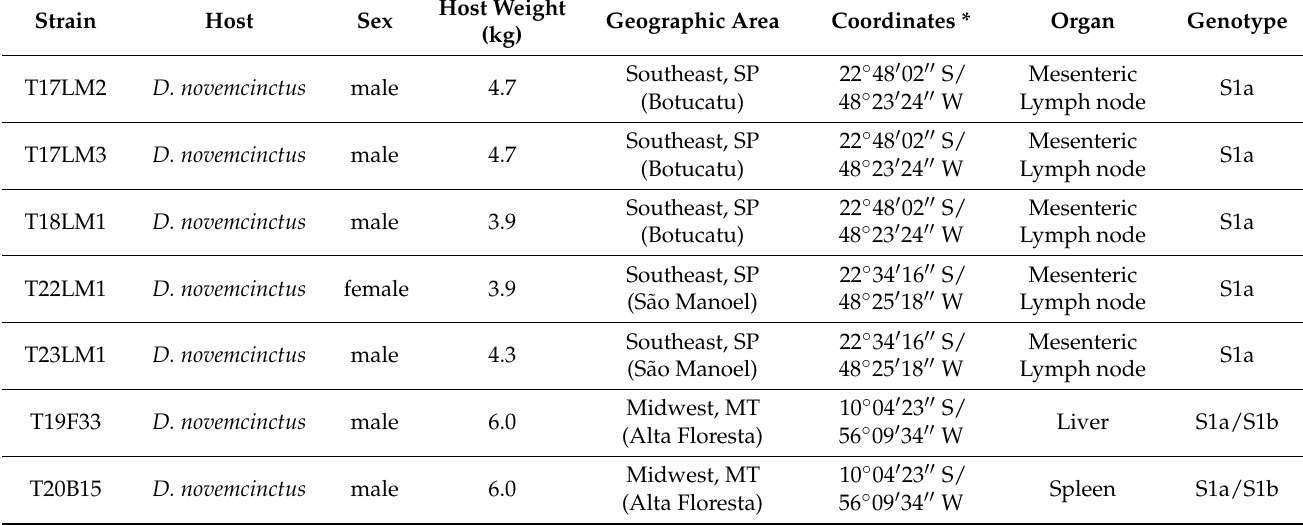
Table 1. Strain, host, sex, host weight, location, geographical coordinates, organ, and genotypes for each of the strains analyzed by whole genome